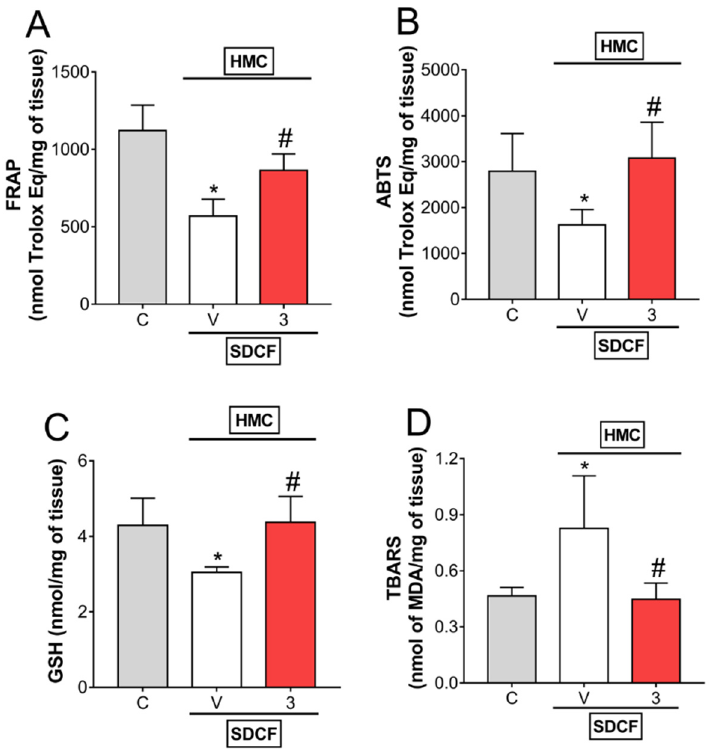
Figure 4. HMC inhibits SDCF-induced oxidative stress in renal tissue. Kidney was collected 24 h after the administration of SDCF for the evaluation of FRAP ( A ), ABTS ( B ), GSH ( C ), and TBARS ( D ) levels. Results are expressed as mean ± SD, n = 6 mice per group per experiment, and are representative of two independent experiments. * p < 0.05 vs. control (C) group; # p < 0.05 vs. vehicle (V) treated group; one ANOVA followed by Tukey’s post hoc test.